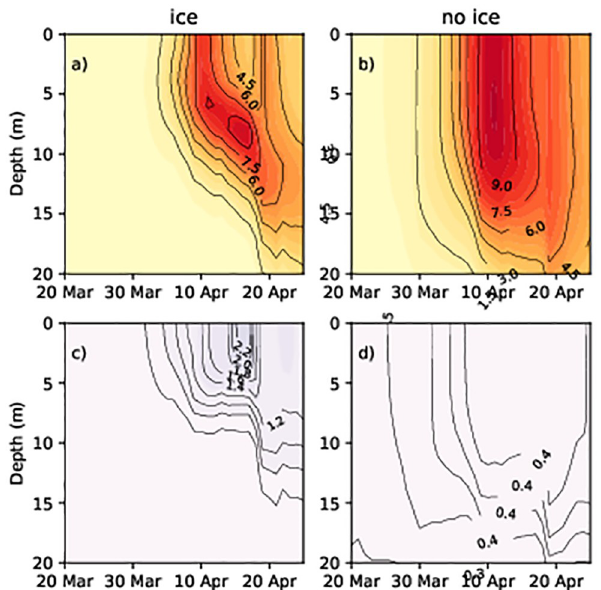
Fig 6. Diatom and flagellate concentrations (Chl mg/m 3 ) at station 14 in spring 2013. (a) Diatoms (no ice run); (b) diatoms (ice run); (c) dinoflagellates (no ice run); (d) dinoflagellates (ice run).